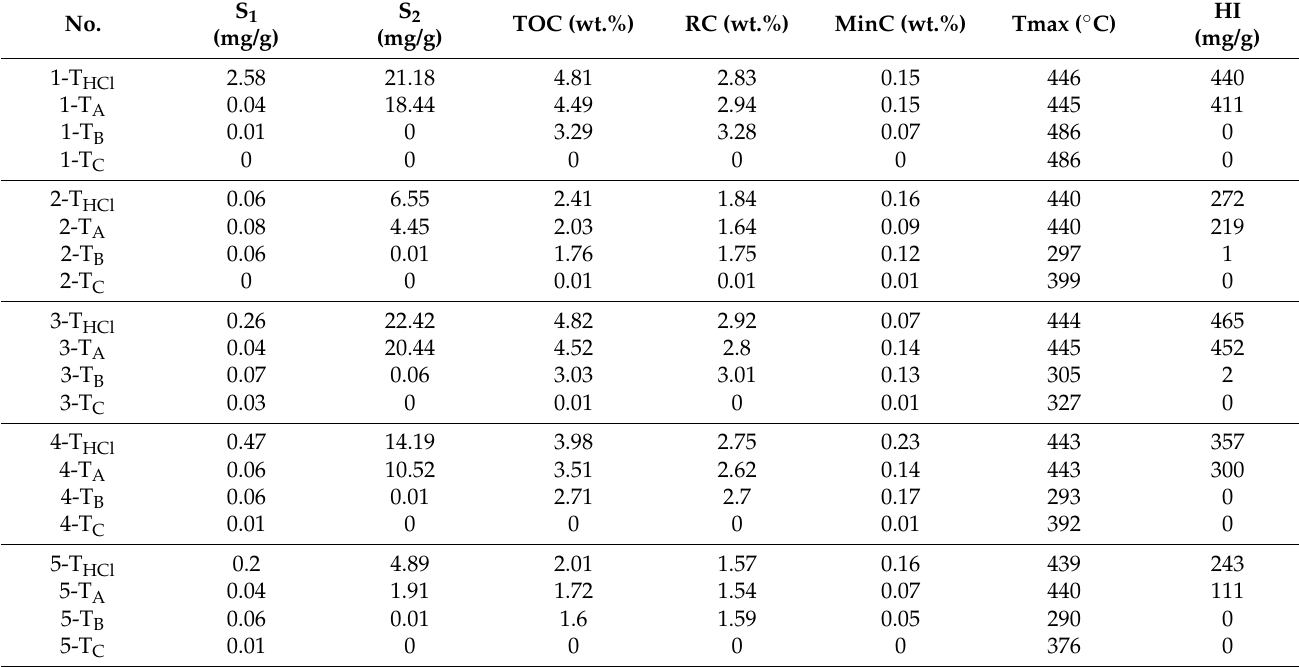
Figure 3. Relative contents of main inorganic minerals in T HCl and adsorbents. I + S: illite + smectite + illite/smectite. Table 2. Rock-Eval analysis data of T HCl and